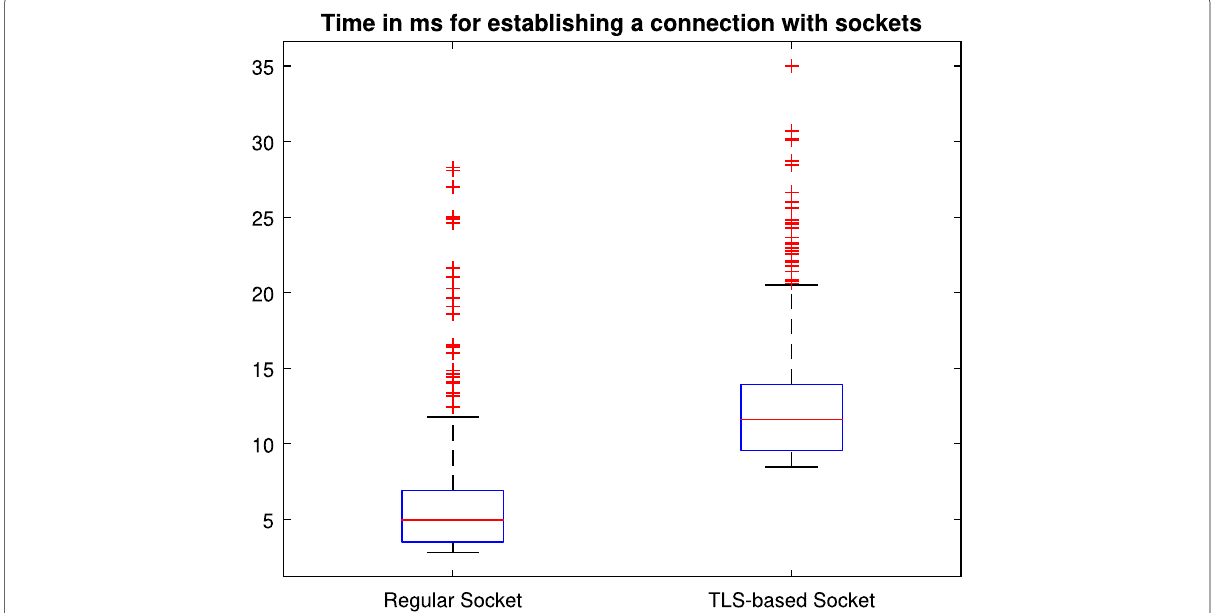
Fig. 3 Connection times in milliseconds (ms) for regular sockets and TLS-based